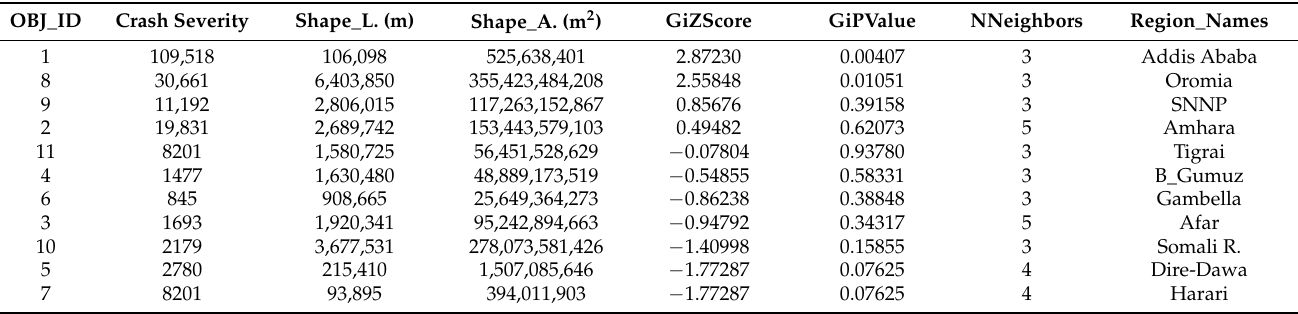
Table 1. Crash Hot Spot Result of Getis Ord Gi*